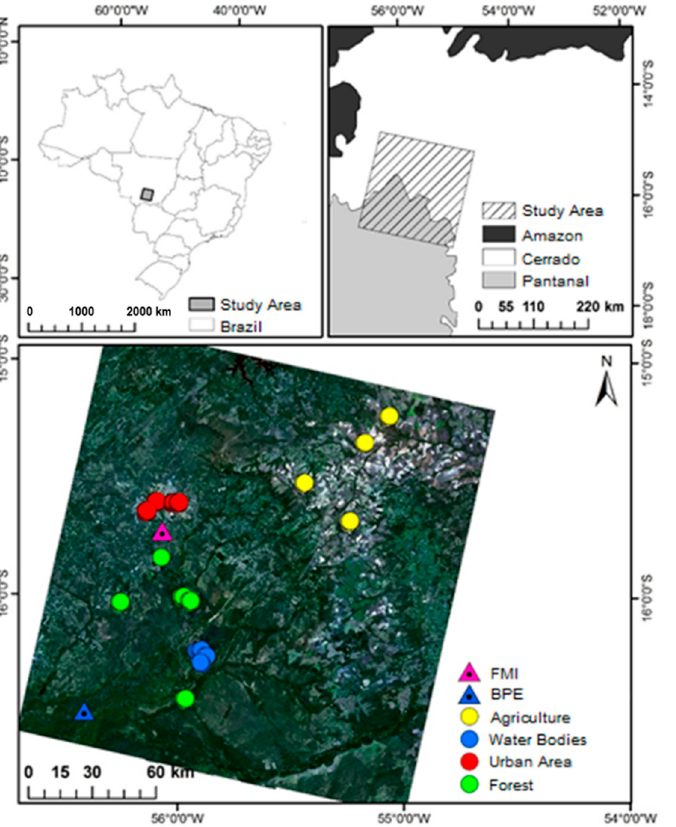
Figure 1. Location of the study area ( top-left ), location of the Cerrado-Pantanal transition region of Mato Grosso, Brazil ( top-right ), and the sample points (circles) and the flux towers in Fazenda Miranda (FMI) and Ba í a das Pedras (BPE) ( bottom ). Table 1. Description of the equipment used to measure incident solar radiation (Rgi), reflected solar radiation (Rgi), net radiation (Rn), soil heat flux (G), air temperature (Ta), relative humidity (RH), wind speed (u), datalogger, and their respective heights in the Fazenda Miranda (FMI) and Ba í a das Pedras (BPE) flux towers.